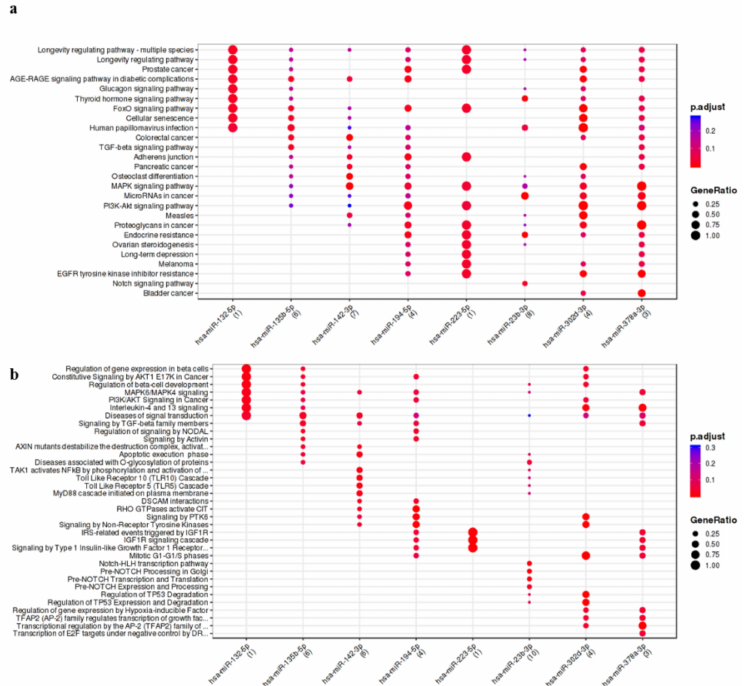
Figure 3. Functional enrichment analysis on miRNA silenced in ASC-EVs primed with IL-1 β . The analysis was conducted by KEGG pathway ( a ) and Wikipathway ( b ). Significant pathways are listed and represented by circles colored according to the significance of the enrichment and their size is proportional to the number of target genes regulating the described signaling